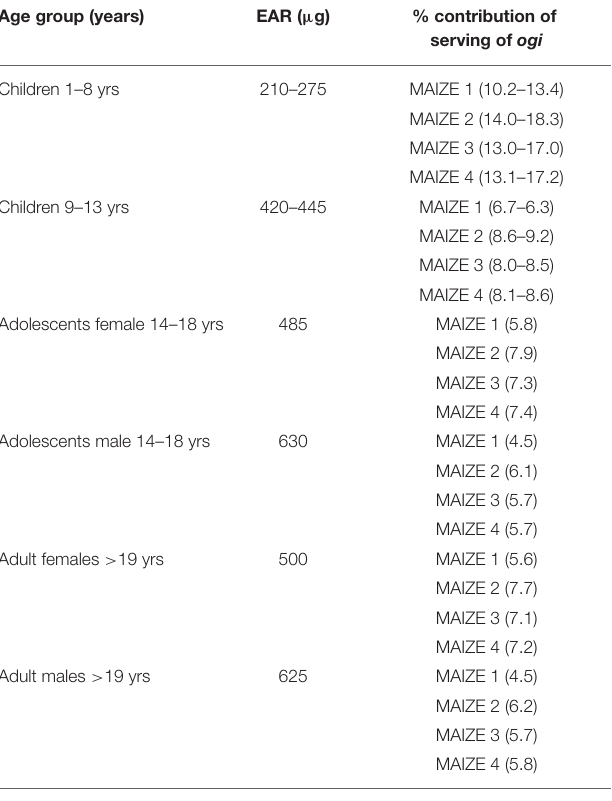
TABLE 5 | Percentage contribution of one serving of ogi pap/porridge (219 g) to TABLE 6 | Phytate content before and after production into ogi estimated average requirement (EAR) of vitamin A. Age group (years) % contribution of serving of ogi